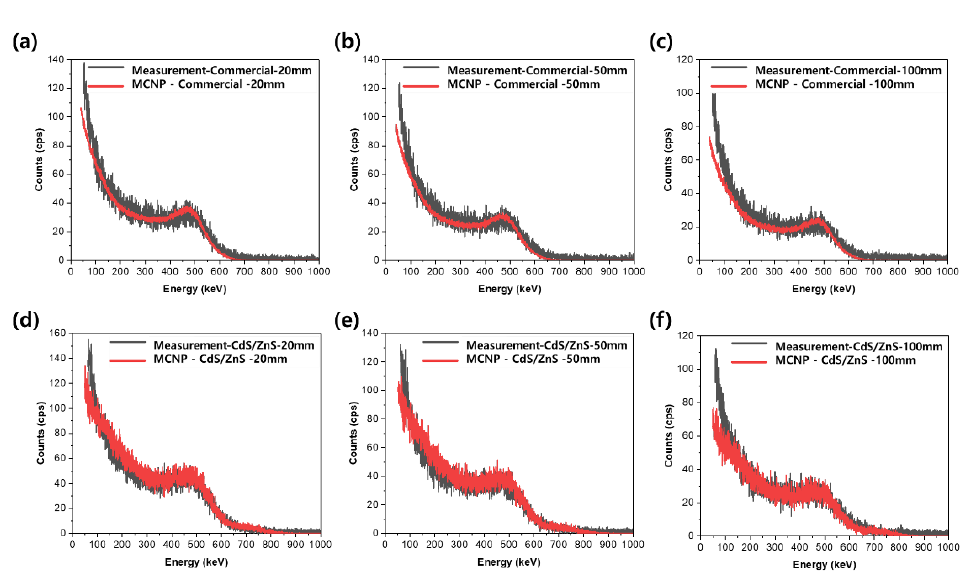
Figure 8. Comparison of measurement results and MCNP simulation results using 30-mm-thick plastic scintillator. ( a – c ) Comparison of results by distance with a source using a commercial scintillator. ( d – f ) Comparison of results by distance with a source using a CdS/ZnS-loaded scintillator.